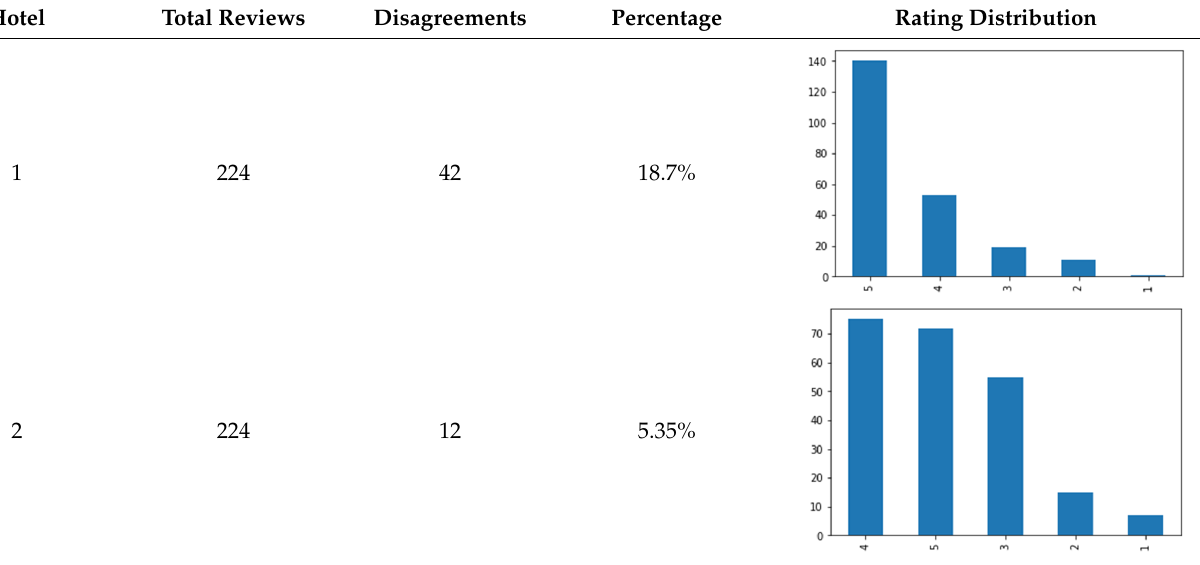
Table 4. Disagreements between the original reviews rating and the rating of the developed deep learning ‐ based sentiment analysis model (left) and the rating distributions of the two hotels (right).